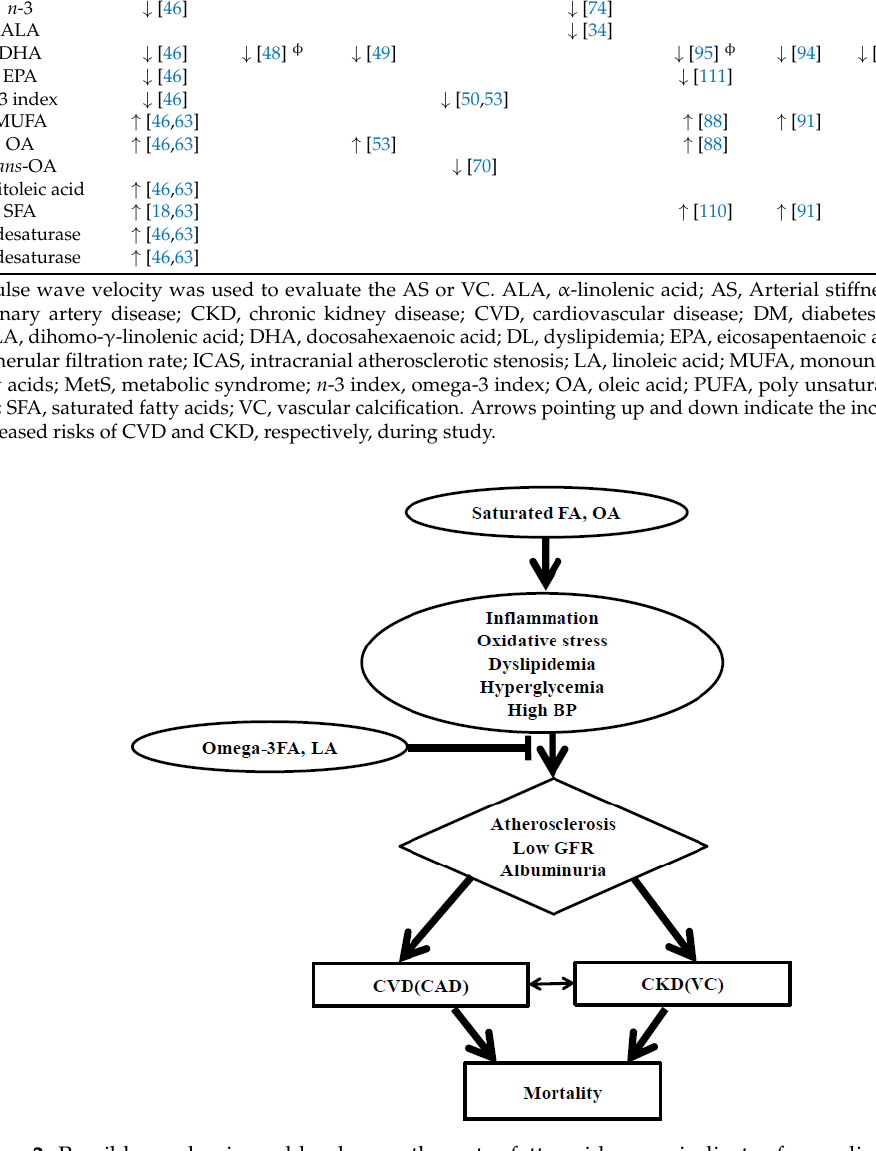
Figure 2. Possible mechanisms: blood or erythrocytes fatty acids as an indicator for cardiovascular disease and chronic kidney disease risk prediction. FA, fatty acids; OA, oleic acid; BP, blood pressure; LA, linoleic acid; GFR, glomerular filtration rate; CVD, cardiovascular disease; CAD, coronary artery disease; CKD, chronic kidney disease; VC, vascular calcification.